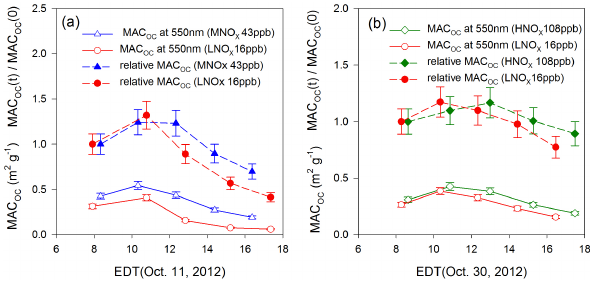
Fig. 2. Comparison of light absorption of wood OA photochemi- cally oxidized at different conditions: (a) low RH vs. medium RH, and (b) low RH vs. high RH. The open symbols are for MAC OC at 550nm. The filled symbols are for the relative MAC OC , which is expressed as the total MAC OC divided by the initial total MAC OC . The uncertainties associated with OC mass absorption cross sec- tion in Eqs. (1)–(3) are estimated using propagation of errors from OC/EC analyzer, UV–visible spectrometer, and the correction fac- tor f (Eq. 5). Uncertainty of OC/EC analyzer was determined by dividing 0.5µgm − 3 (the absolute error) by the measured OC value. Uncertainty of the UV–visible spectrometer was determined by di- viding 0.002 (the absolute error) by the measured absorbance. The standard error of f is 8%, which is estimated from the linear re- gression of calibration data (Zhong and Jang, 2011).